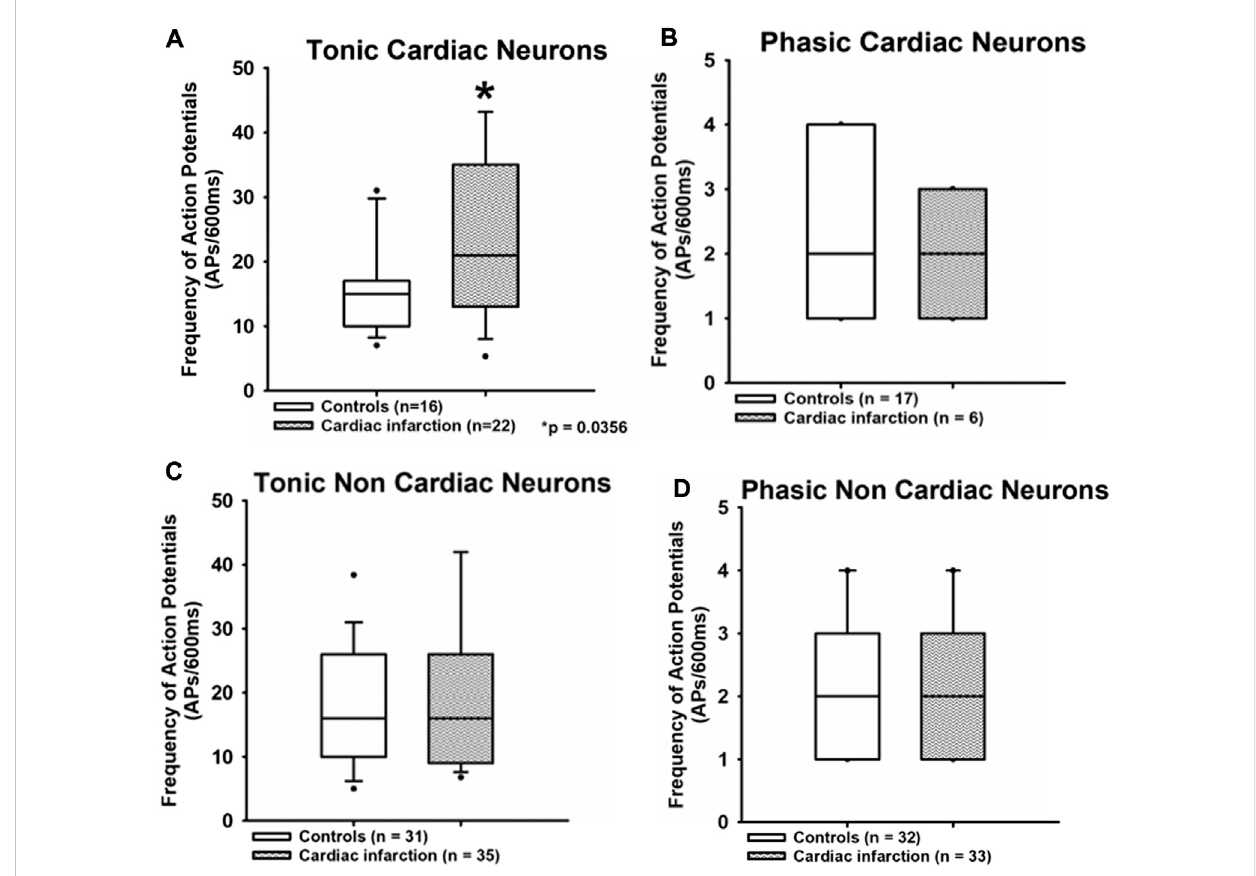
FIGURE 3 Myocardial infarction altered the frequency of action potential fi ring in tonic neurons. The frequency of action potentials (APs/600 ms) due to currentinjectionwaspresented.Upperpanels (A,B) :thefrequencyofactionpotentialswassigni fi cantlyincreasedinthetoniccardiacneuronsofratswith myocardial infarction [cardiac control: 15 APs/600 ms (10.8; 16.3) vs. cardiac after myocardial infarction: 21 APs/600 ms (14; 38.5)] * p < 0.05. Lower panels (C,D) : neurons with a phasic fi ring pattern exhibited no signi fi cant differences in frequencies of action potentials in rats with myocardial infarction. Shown are the medians, the 25th/75th (box boundaries) and the 10th/90th percentiles (black dots). Kruskal – Wallis one-way ANOVA on ranks was used with Dunn ’ s post - hoc method. Neurons were investigated in the voltage clamp mode of patch clamp